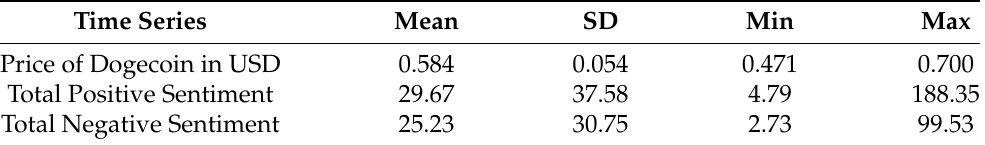
Table 1. Summary statistics of the three time series. The negative sentiment scores are in absolute value for convenience of